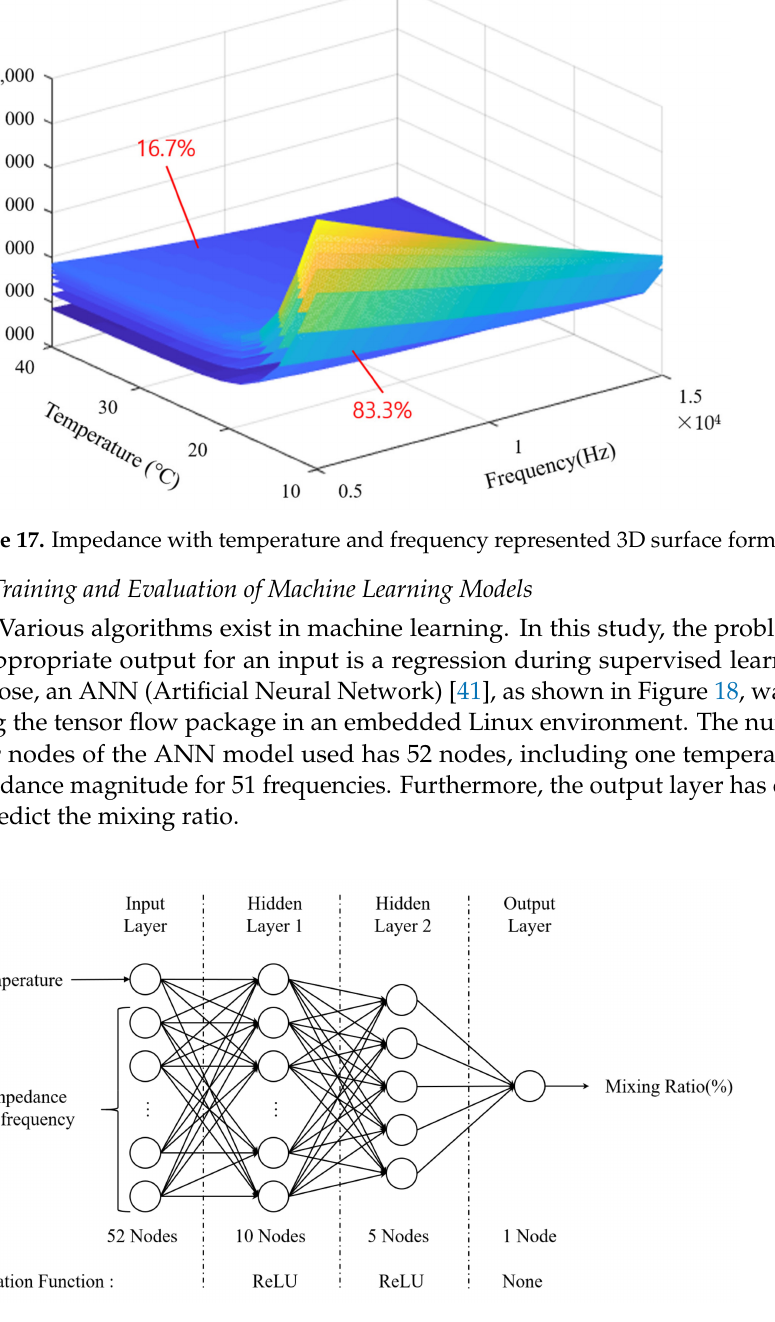
Figure 18. The ANN model with activation function for